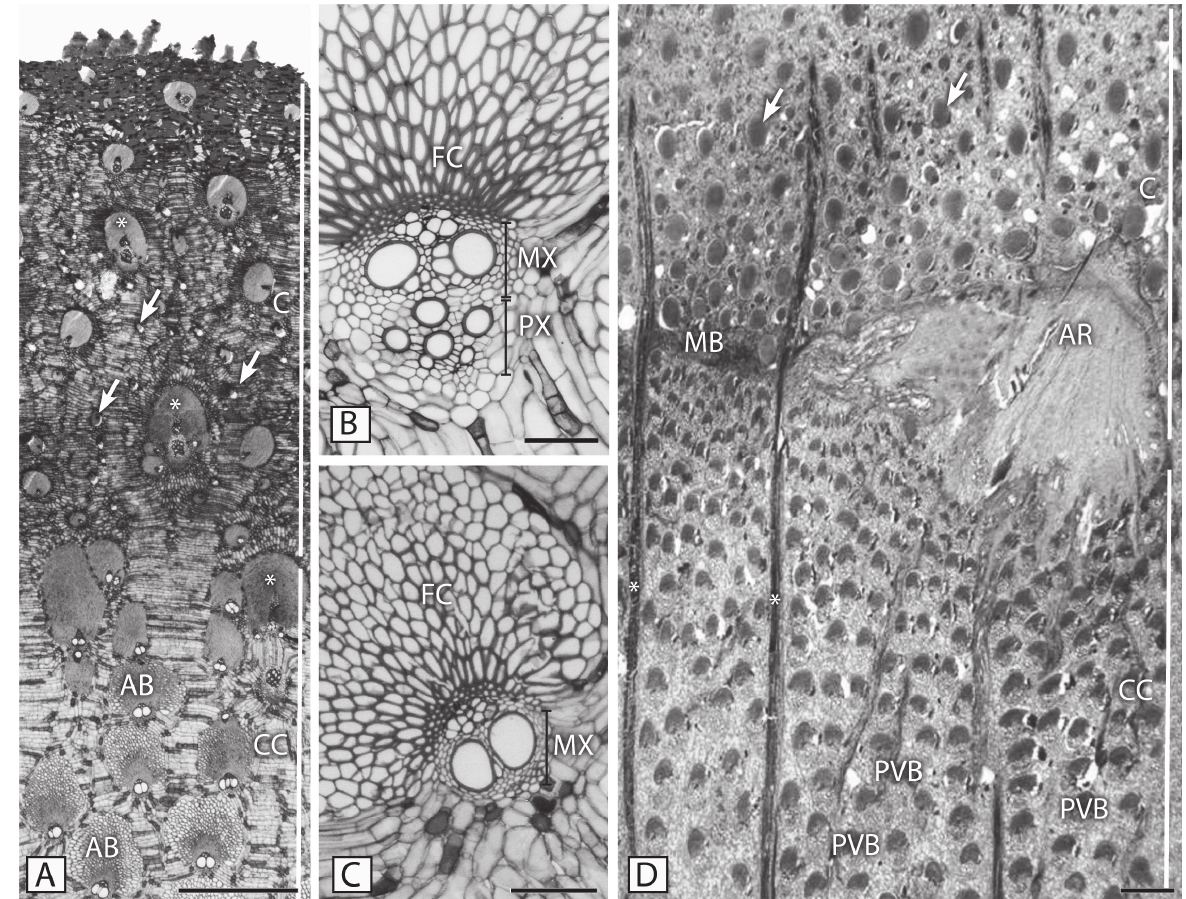
Figure 2 - A - D. Transverse sections of stem. A - C. Syagrus romanzoffiana . Adult tree. A. Cortical region (C) , and central cylinder (CC) with leaf traces and axial bundles. B. Detail of a leaf trace. C. Detail of an axial bundle. D. Attalea geraensis . Short stem. Cortical region (C) and central cylinder (CC) . Note the meristematic band (MB) and a stem borne root (AR) . Arrows: fiber strands, Asterisks: leaf traces, AB: axial bundle, FC: fiber cap, MX: metaxylem; PVB: primary vascular bundle; PX: protoxylem. Scale bars: 10 µm (A) ; 100 µm (B) ; 50 µm (C) ; 1m (D)